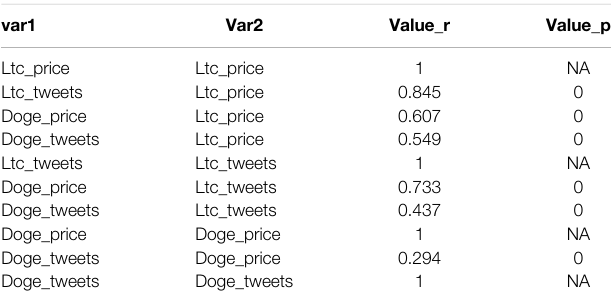
Doge_tweets Doge_price